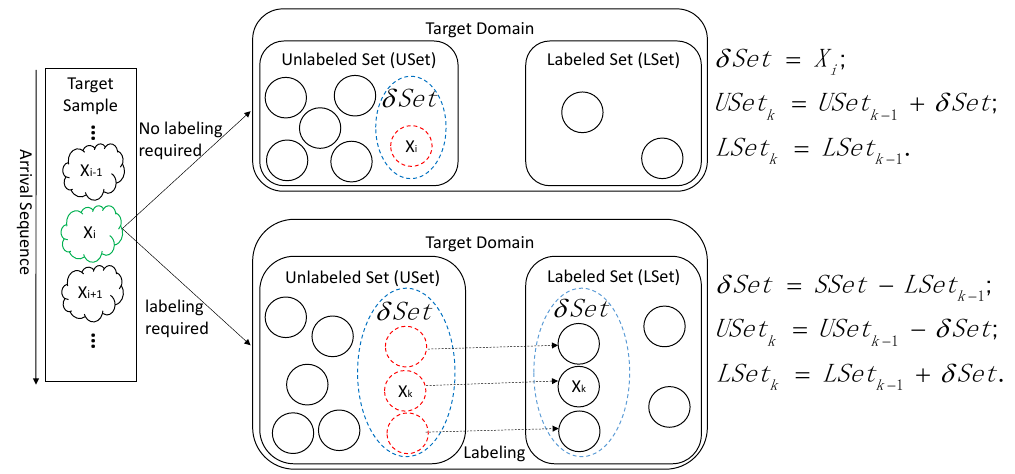
Figure 1. Demonstration of sample changes in the target domain during online processing. SSet is the selected sample in the target domain received to date based on some sample selection algorithm, and δ Set is the incremental (decremental) set in labeled (unlabeled) set. For arrival sample X i , two cases regarding whether to perform selection and labeling is given in the